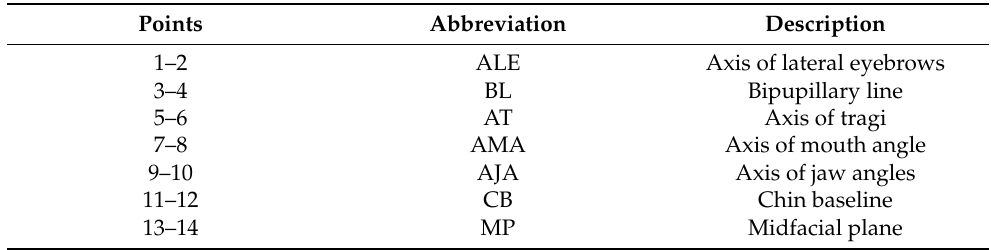
Table 2. Axes between two defined points (see Figure 6). Six angles between each axis and the midfacial plane are determined.